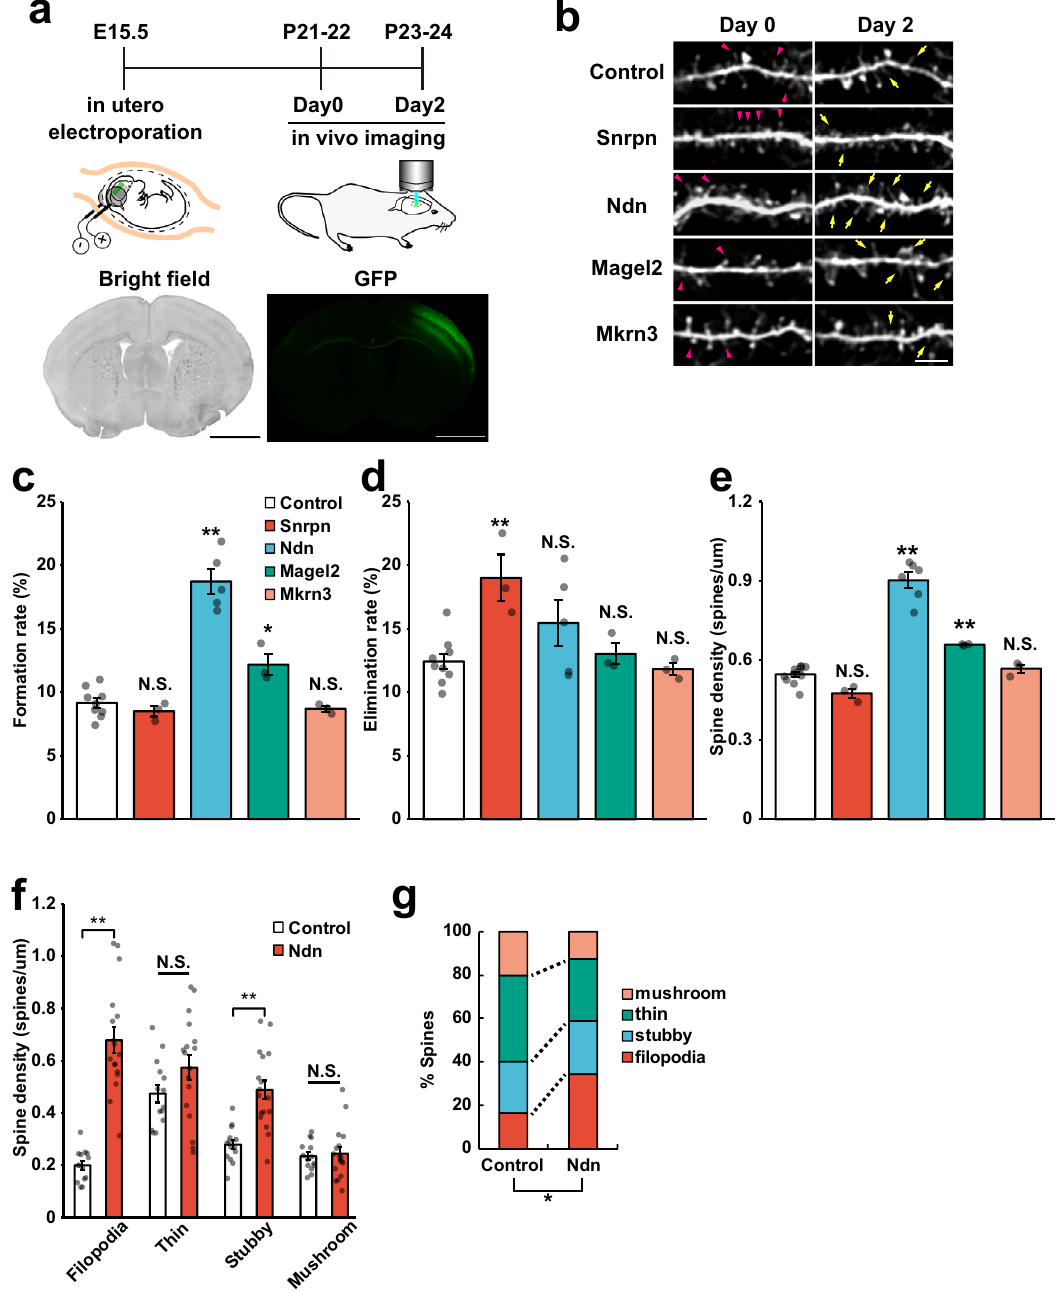
Fig. 3 Ndn regulates formation and maturation of dendritic spines. a (Upper): Experimental schedule for in vivo imaging. (Bottom): images of somatosensory cortex electroporated with GFP plasmid at postnatal 3 weeks (P21-24). b Representative images of dendritic spines by in vivo time-lapse imaging. Arrows and arrowheads indicate newly formed and eliminated spines within 2 days, respectively. Similar images were obtained in the independent mice (at least more than 3). c , d Quanti fi cation of spine dynamics by introducing each 15q11-13 PEG. c Spine formation rate and d elimination rate are shown. N = 9 biologically independent mice (control), 5 ( Ndn ) and 3 ( Mkrn3 , Magel2 , and Snrpn ). Formation rate: Snrpn : p = 0.9205, Ndn : p < 0.0001, Magel2 : p = 0.0197, Mkrn3 : p = 0.9764. Elimination rate: Snrpn : p = 0.0046, Ndn : p = 0.1644, Magel2 : p = 0.9927, Mkrn3 : p = 0.9926. e The density of spines was evaluated by immunohistochemistry using the anti-GFP antibody. N = 12 biologically independent mice (control), 6 ( Ndn ) and 3 ( Mkrn3 , Magel2 , and Snrpn ). Spine density: Snrpn : p = 0.0688, Ndn : p < 0.0001, Magel2 : p = 0.0022, Mkrn3 : p = 0.8872. f , g Classi fi cation of each spine. f Spine density in each class. Filopodia: p < 0.0001, Thin: p = 0.1, Stubby: p < 0.0001, Mushroom: p = 0.720. g Proportion of each classi fi ed spine. N = 14 (control) and 17 ( Ndn ) of the dendrites from biologically independent three mice. ** p < 0.01, * p < 0.05 ( c – e : Dunnett ’ s test, f : t -test after correction for multiple testing by Benjamini – Hochberg procedure, g : chi-squared test). Scale bar for a , 500 μ m; b , 5 μ m. Data are represented as mean ± s.e.m. N.S. not statistically signi fi